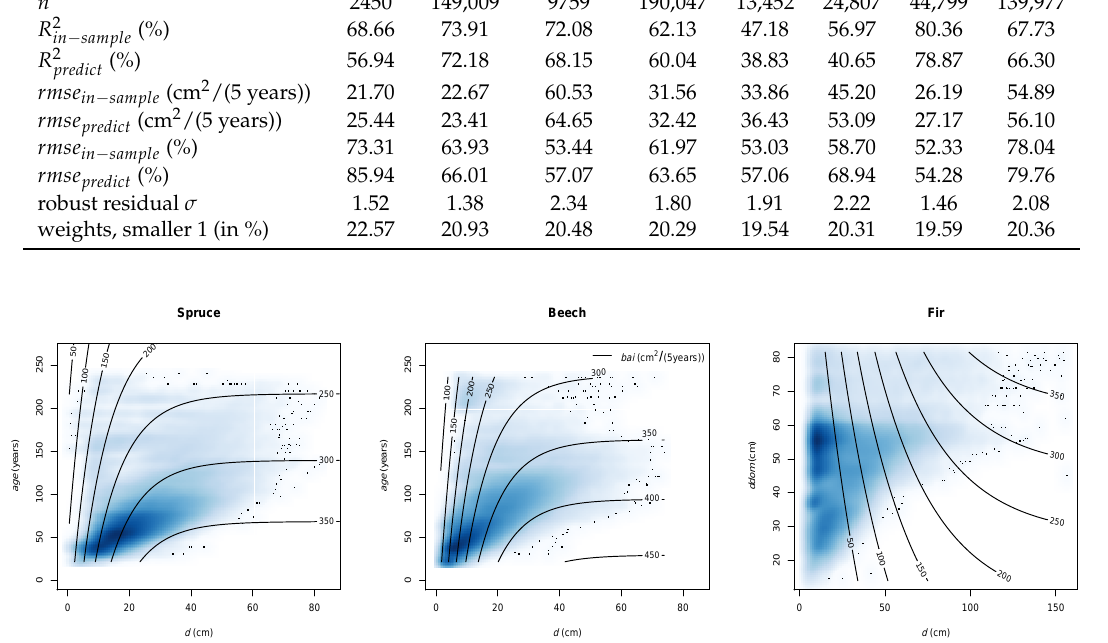
Figure 5. Effects of the stand development measured by age or ddom (quadratic mean diameter of dominant trees) on mean expected growth. The blue background is the two-dimensional density of the observed age and diameter values. Dark blue contains more